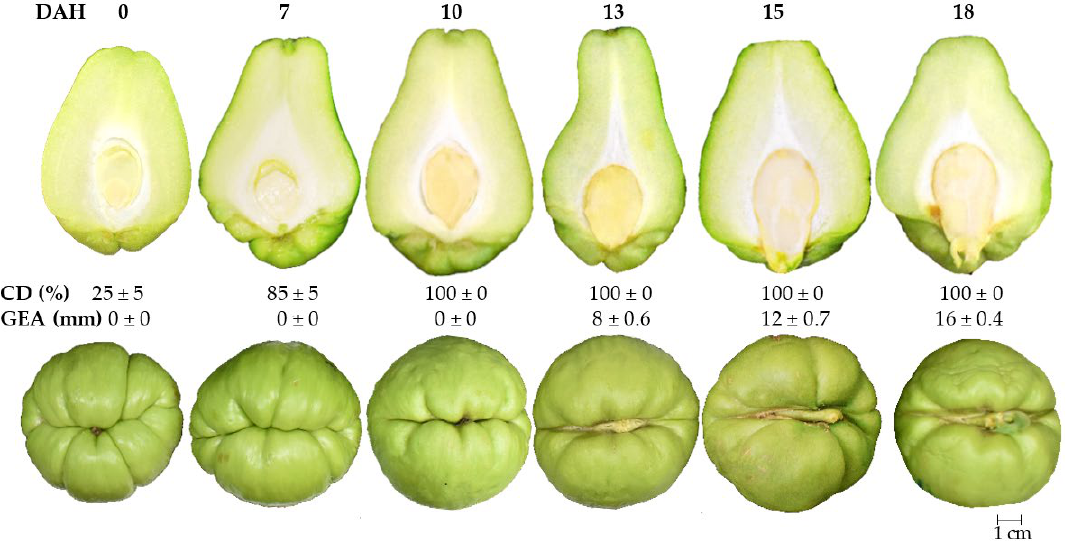
Figure 6. Postharvest characteristics of seed development, cotyledons, and embryonic axis of chayote Sechium edule var. virens levis . DAH = days after harvest; CD = cotyledon development; GEA = growth embryonic axis ( n = 3 ± standard deviation).